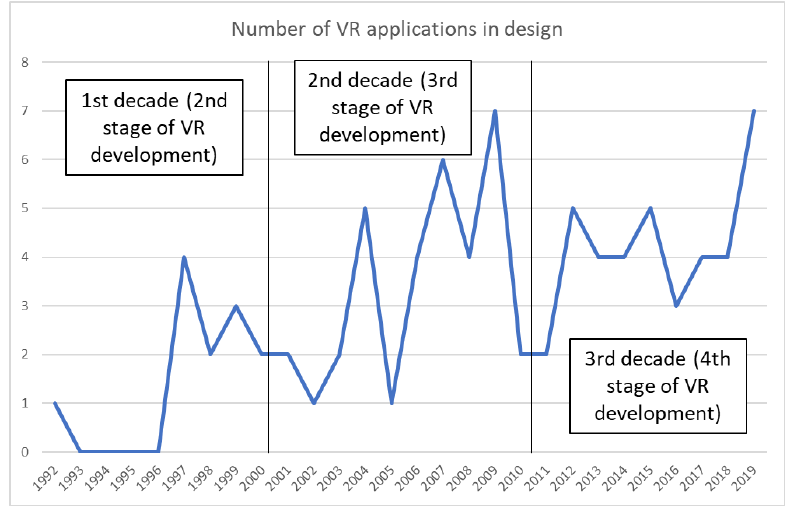
Figure 3. Number of VR applications in design evaluated in terms of the publication years of the reference scientific sources.